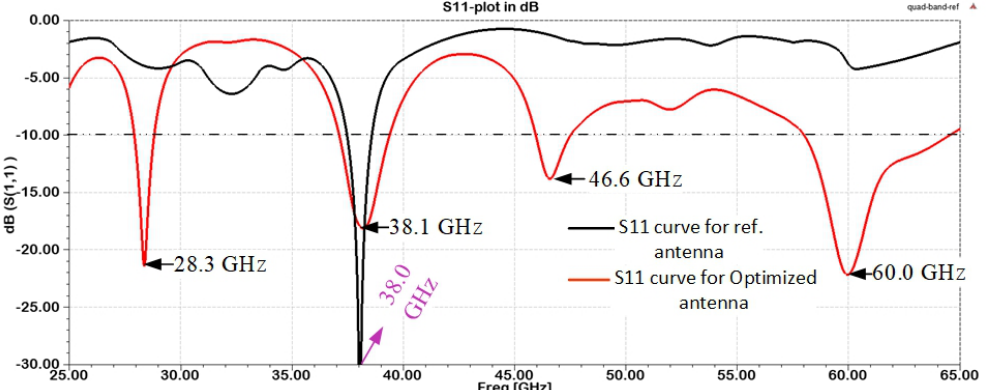
Figure 5. Simulated results of S 11 for genetically optimized antenna and reference